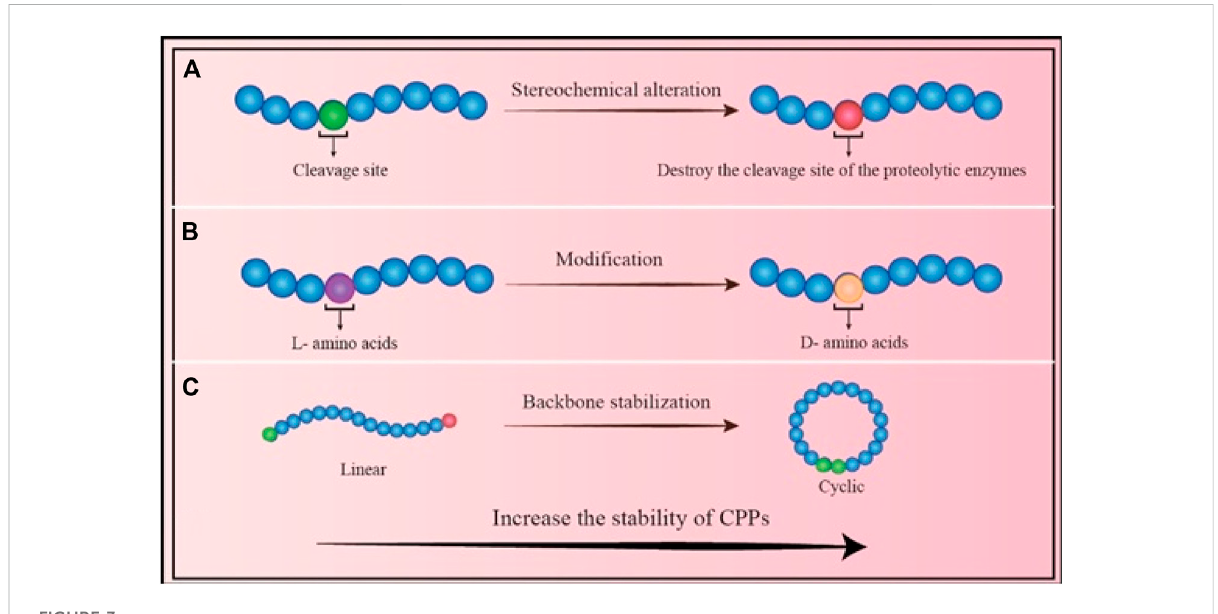
FIGURE 3 DifferentstrategiestoincreasethestabilityofCPPs: (A) Stereochemicalalterationmethod:Chemicalmodi fi cationoftheresidueseliminatesthe sensitivity of CPP; (B) Amino acid modi fi cation: Changing the residues to a different isomer can increase the stability of CPP; (C) Backbone stabilization: Converting the linear form to a circular CPP reduces the CPP ’ s sensitivity to enzymes, and increases its